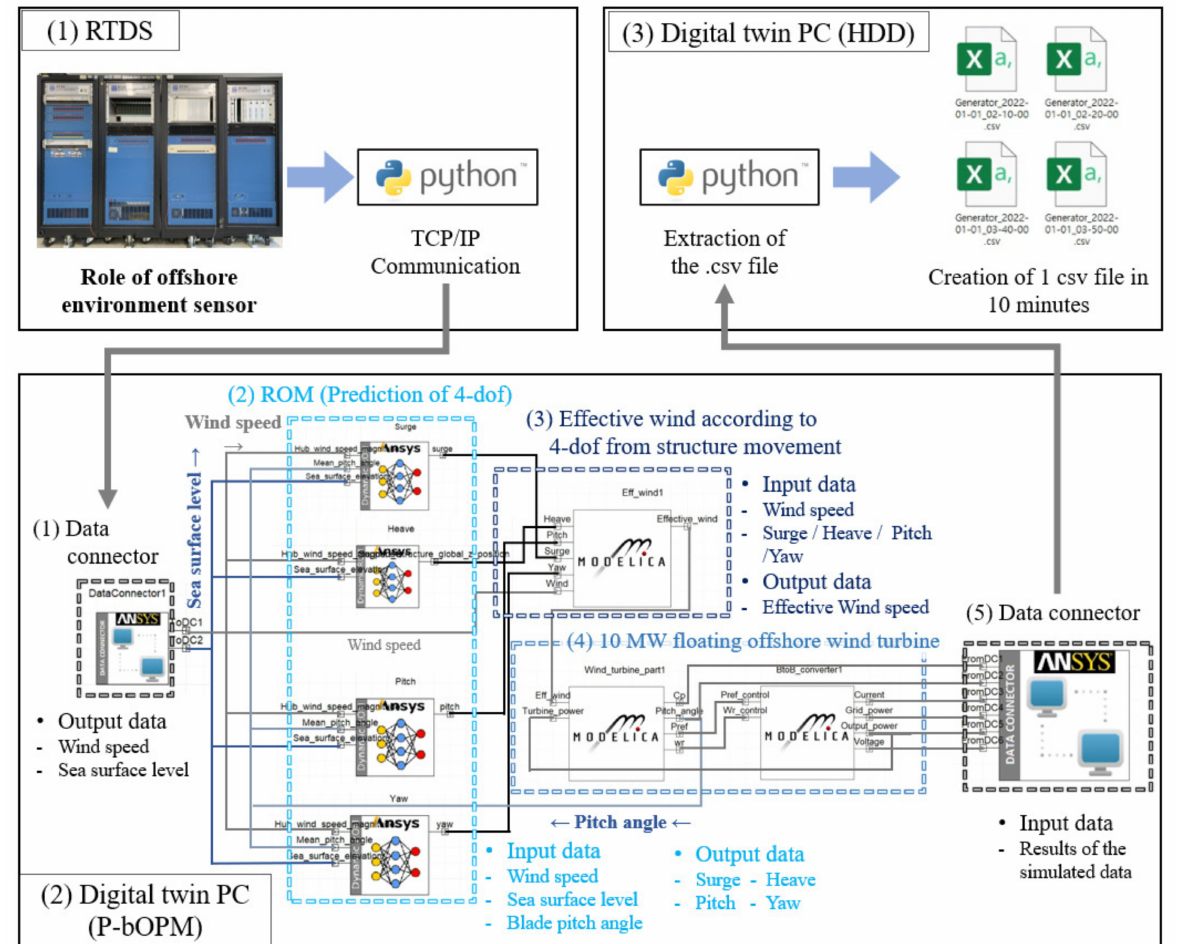
Figure 7. The 10 MW FOWT model for real-time simulation by using data connector and